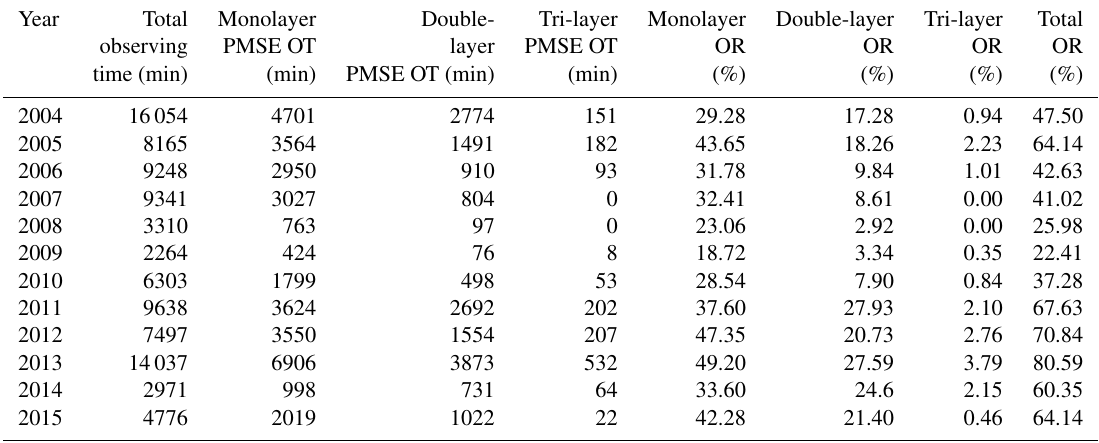
Table 3. Statistical data from 2004 to 2015.